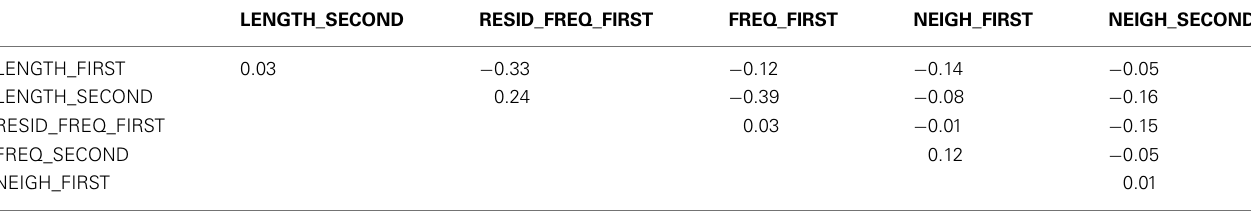
TableA2 | Correlation matrix of predictors used in all stimuli analysis after residualization (values indicate pairwise Pearson correlations).